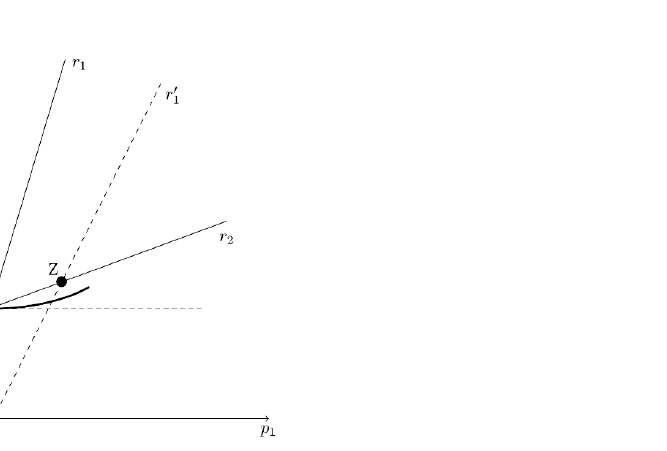
Figure 8. Owner 1’s Incentive to Hire a CEO Who Underestimates Product Substitutability in the Bertrand Model.